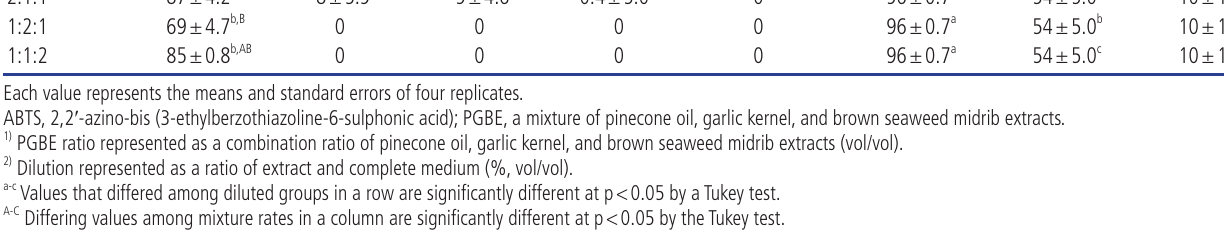
Table 3. Effects of PGBE complex on milk yield and composition in dairy cows Items